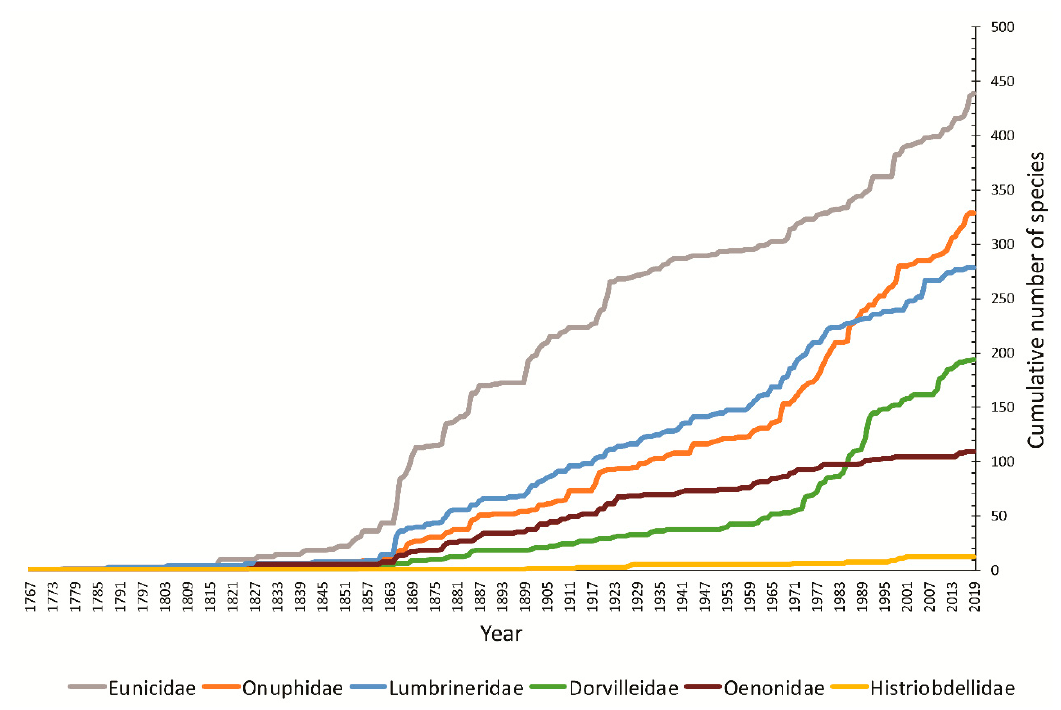
Figure 2. Cumulative number of species described in six eunicidan families, data on valid species only [15] (Hartmaniellidae not shown).